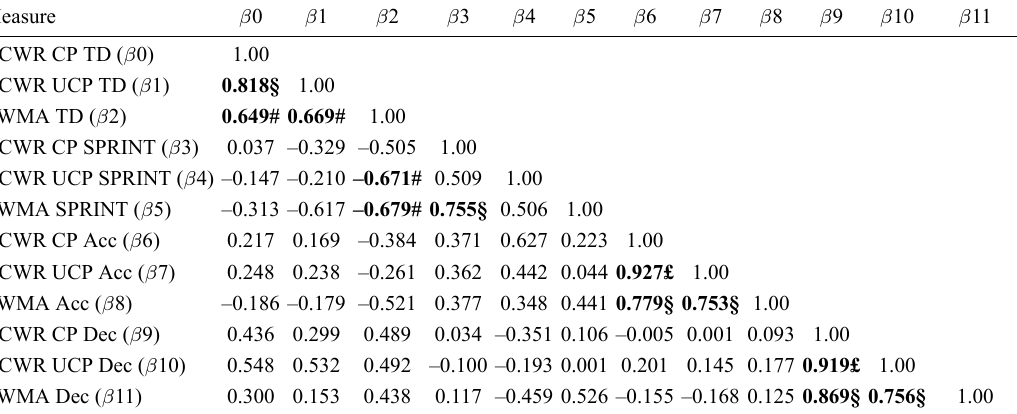
Table 3. Correlation analysis between measures during the season for